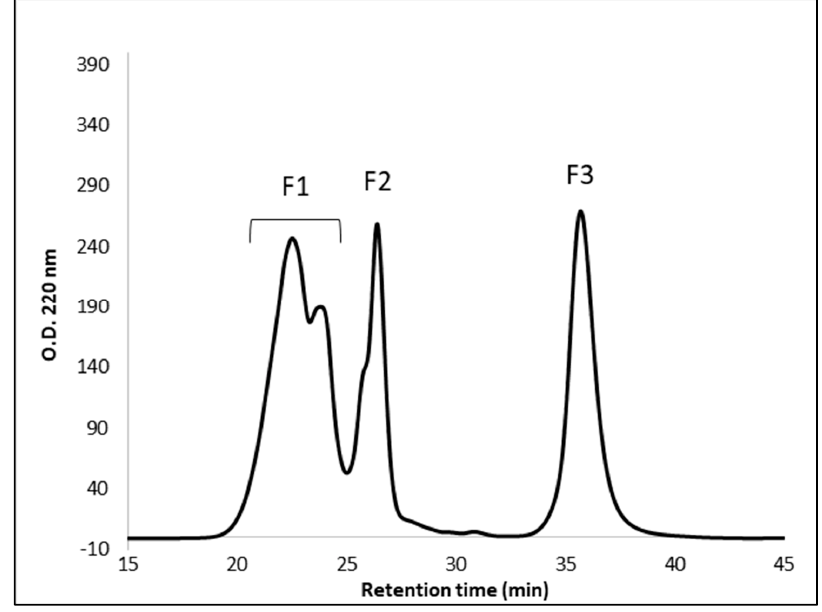
Figure 6. Size-exclusion chromatogram of fractionated canary seed cultivar C09052 3K permeate. F1, fraction 1; F2, fraction 2; F3, fraction 3.